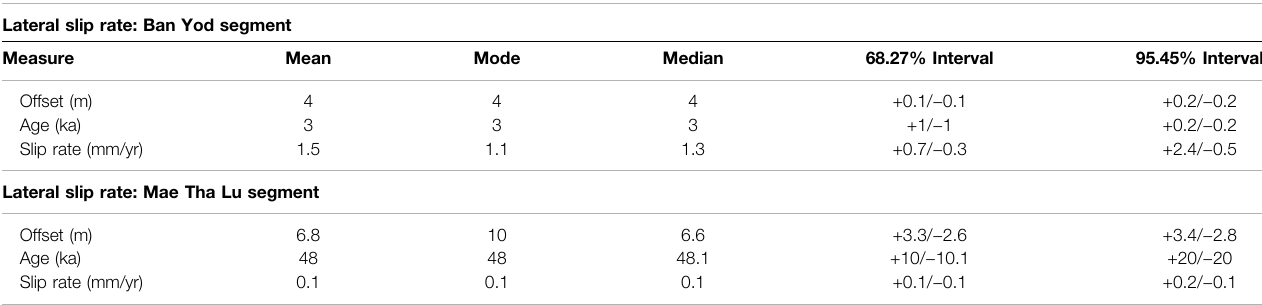
TABLE 3 | Rates of right-lateral strike-slip faulting along the Mae Hong Son